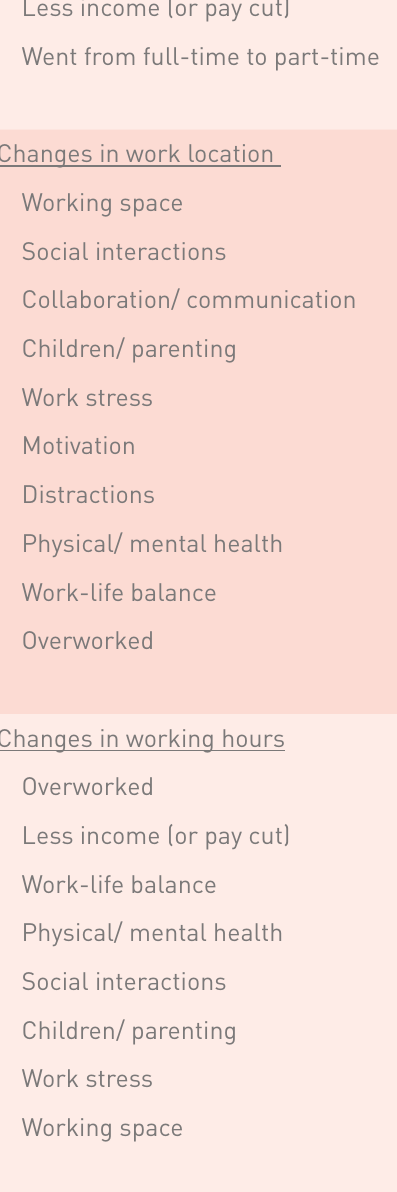
Changes in work location Working